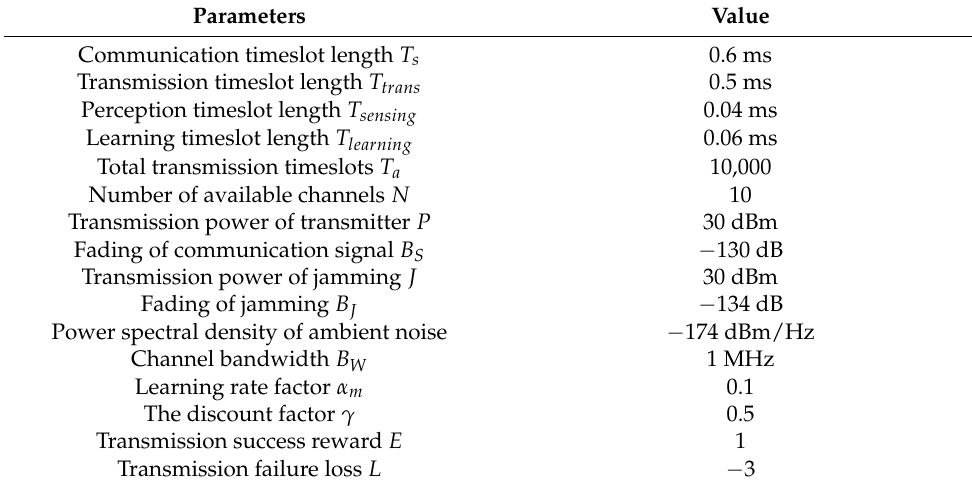
Table 1. Simulation parameter